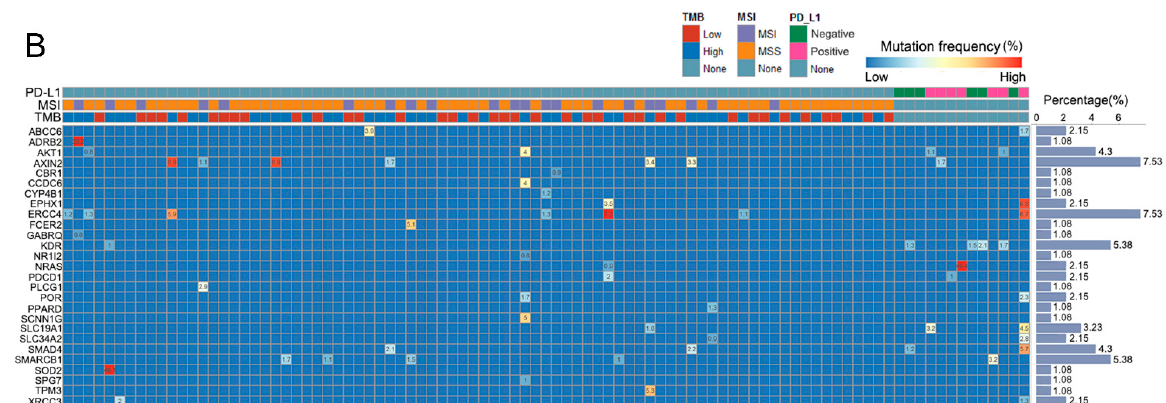
Figure 1. The shared mutated genes between TMB-H, MSI and PD-L1-positive groups. ( A ) Venn diagram of unique mutated gene from TMB-H, MSI and PD-L1-positive groups. There were 27 common genes in the three groups, and these genes appeared in at least two groups. ( B ) Heatmap showing the mutation frequency and percentage of 27 common genes in different groups. These genes had different mutation frequencies and percentages among these patients.